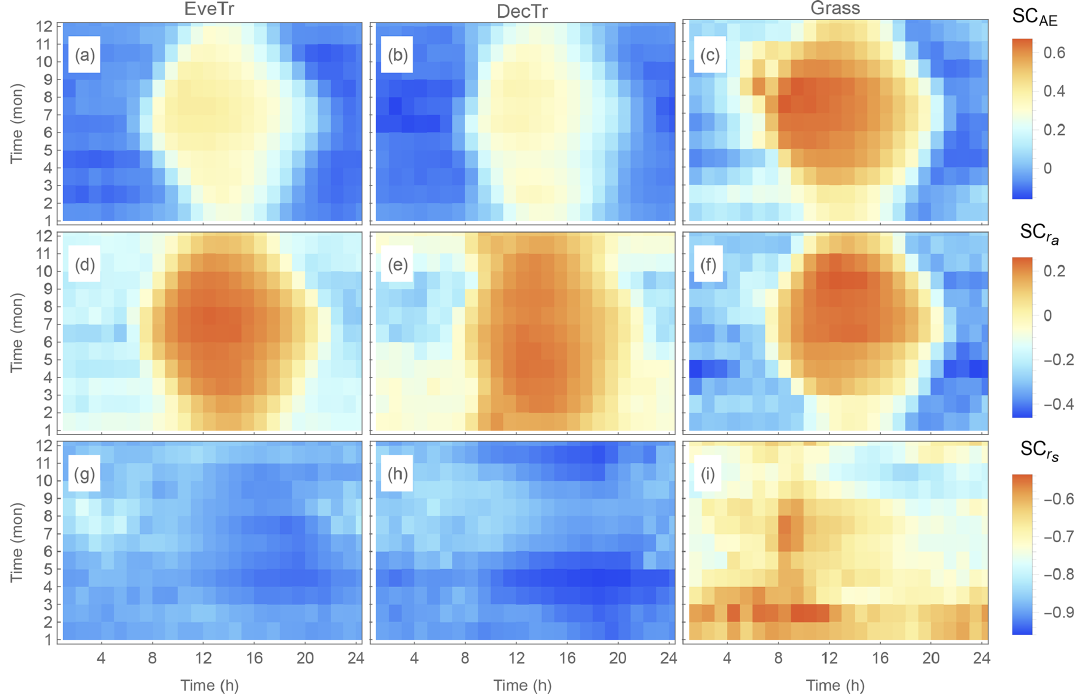
Figure 12. Temporal variation in median (colour) sensitivity coefficient (SC, Eq. 38) of (a–c) available energy (AE, Sect. 5.1), (d–f) aerody- namic resistance ( r a ) and (g–i) surface resistance ( r s ) for ( a , d and g ) evergreen trees (EveTr), ( b , e and h ) deciduous trees (DecTr), and ( c , f and i ) grassland and crops